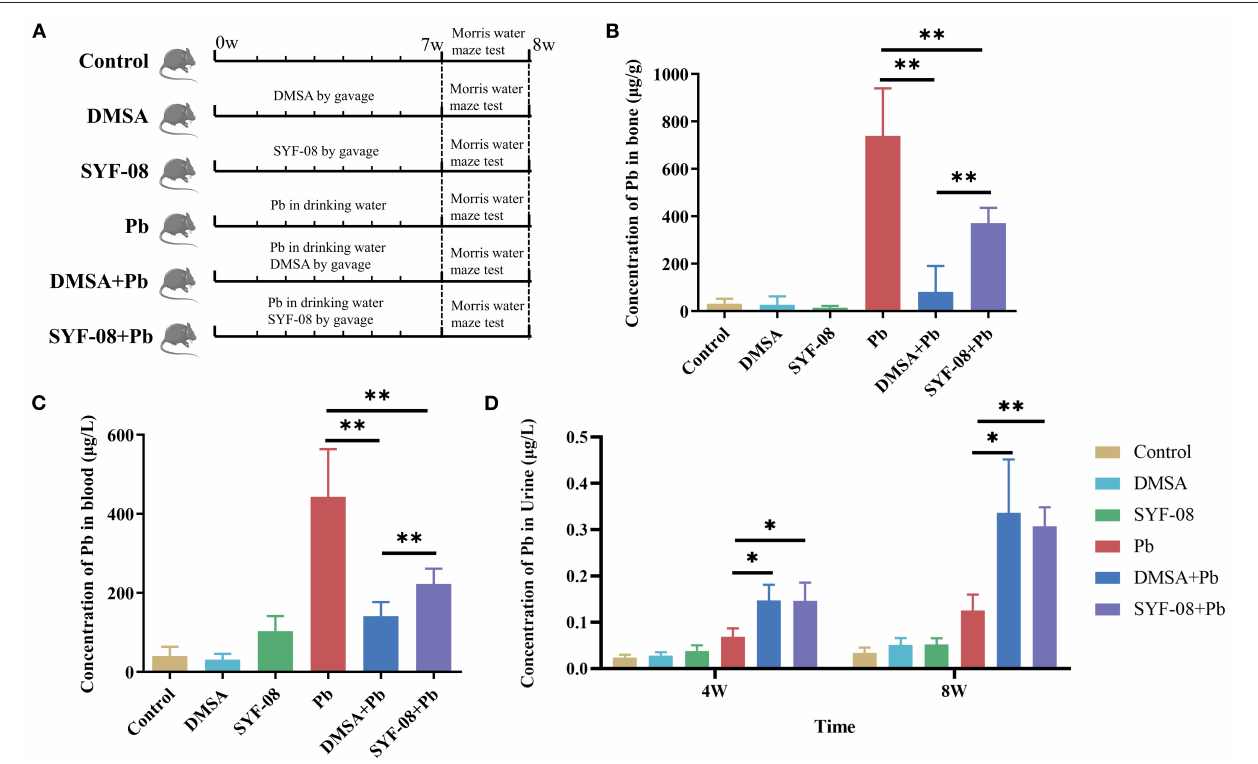
FIGURE 1 | Animal model and Pb levels in organisms. (A) Overview of the study design and samples collection. The concentration of Pb in (B) bone, (C) blood, and (D) urine. * P < 0.05; ** P <